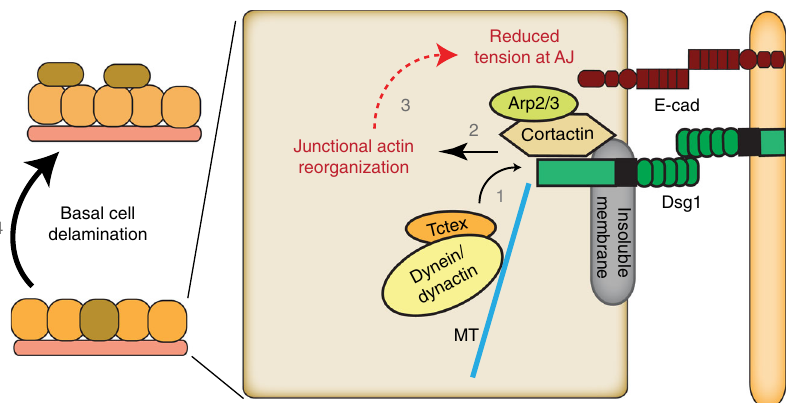
Fig. 9 Diagram summarizing the fi ndings of the present study. The sequence of events is required for initial steps of strati fi cation. Newly synthesized Dsg1 is required for the Tctex-1 – dynein complex to be localized at the cell – cell interface in the insoluble membrane compartment (1) where Dsg1